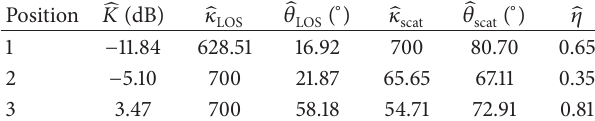
Table 2: Estimated parameters at the three positions.